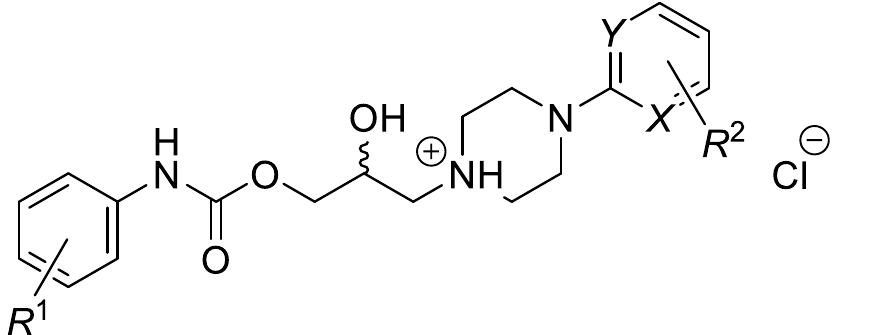
Figure 1. Structure of synthesized 1-[3-(2-/3-/4-alkoxyphenylcarbamoyloxy)-2-hydroxypropyl]-4- [(substituted)phenyl/pyrimidin-2-yl]piperazin-1-ium chlorides.